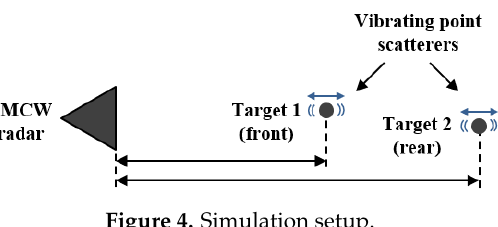
Figure 4. Simulation